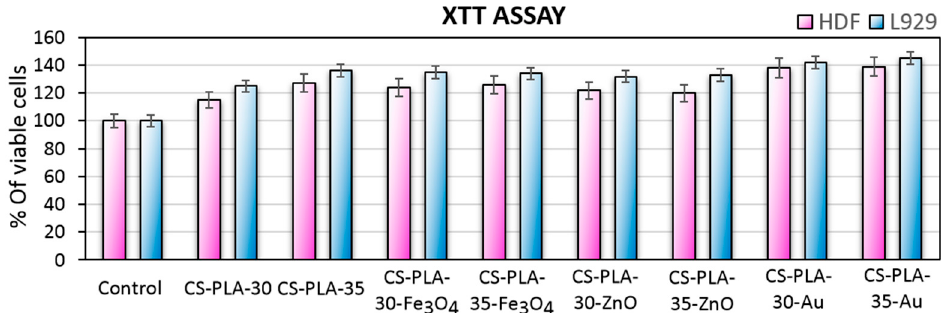
Figure 10. Metabolic activity of L929 mouse fibroblasts cell line and human dermal fibroblasts (primary cells).